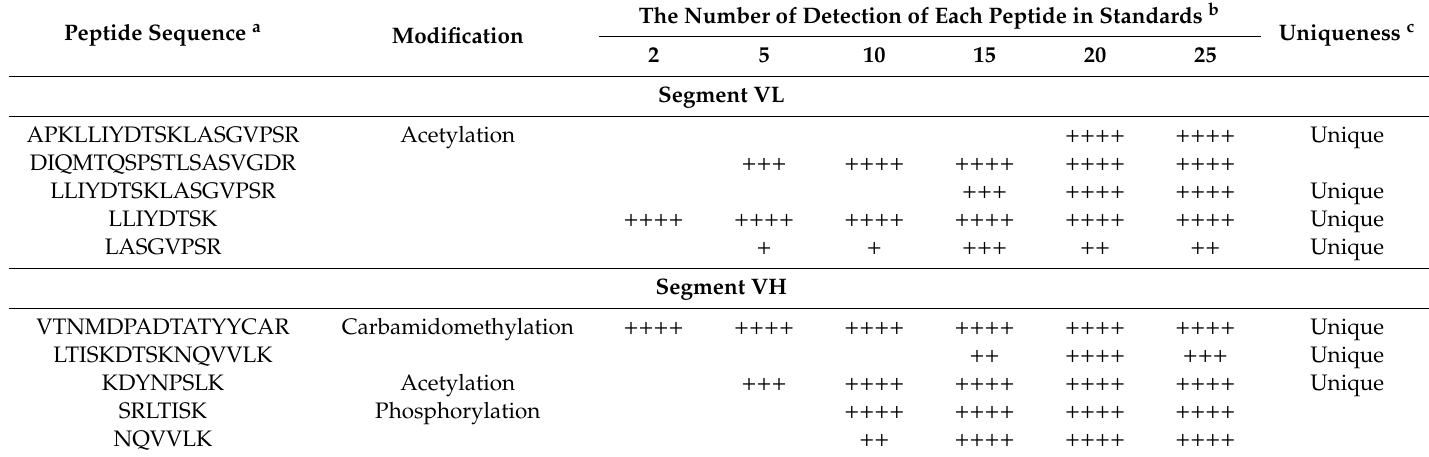
Table 1. List of tryptic peptides derived from palivizumab VL and VH segments. Peptide Sequence